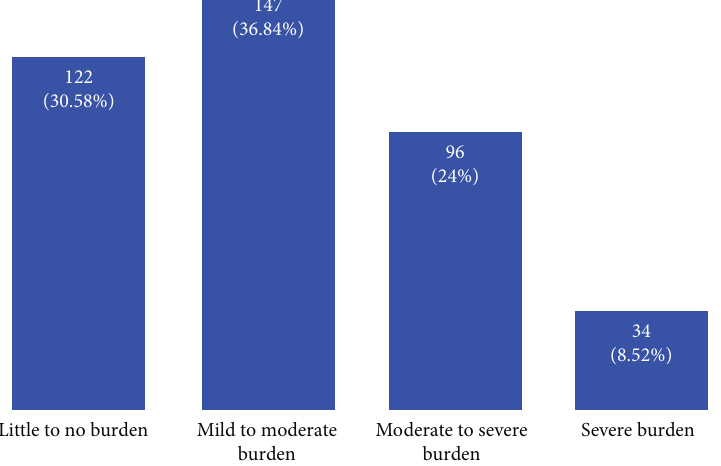
Figure 1: Level of persons with diabetes ’ perceptions of family burden and associated factors at a university